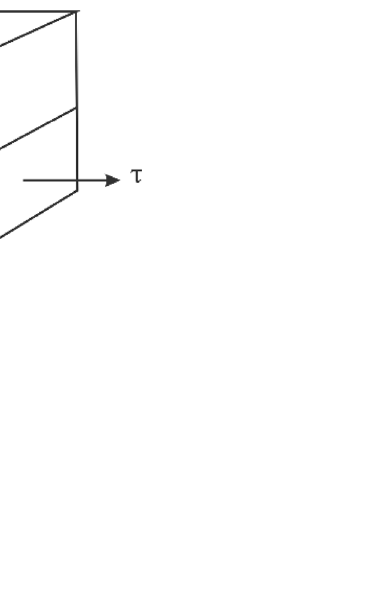
Figure 8. Sawtooth samples for direct shear